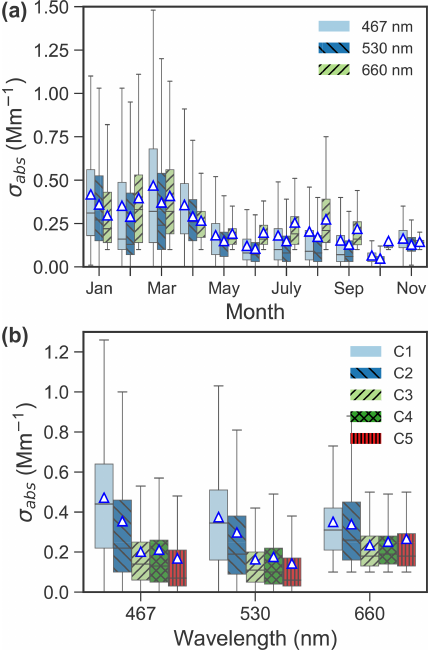
Figure 5. (a) Seasonal variation of absorption coefficient ( σ abs ) at wavelengths of 467, 530 and 660nm in 2015–2019, and (b) boxplot of absorption coefficient at the three wavelengths for each cluster. The mean values are marked as triangles.